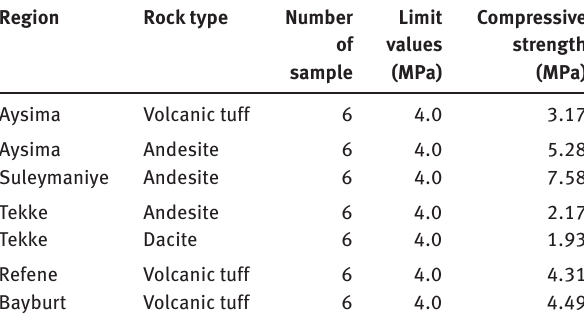
Table 10 According to 7-day compressive strength values, pozzolanic activity of